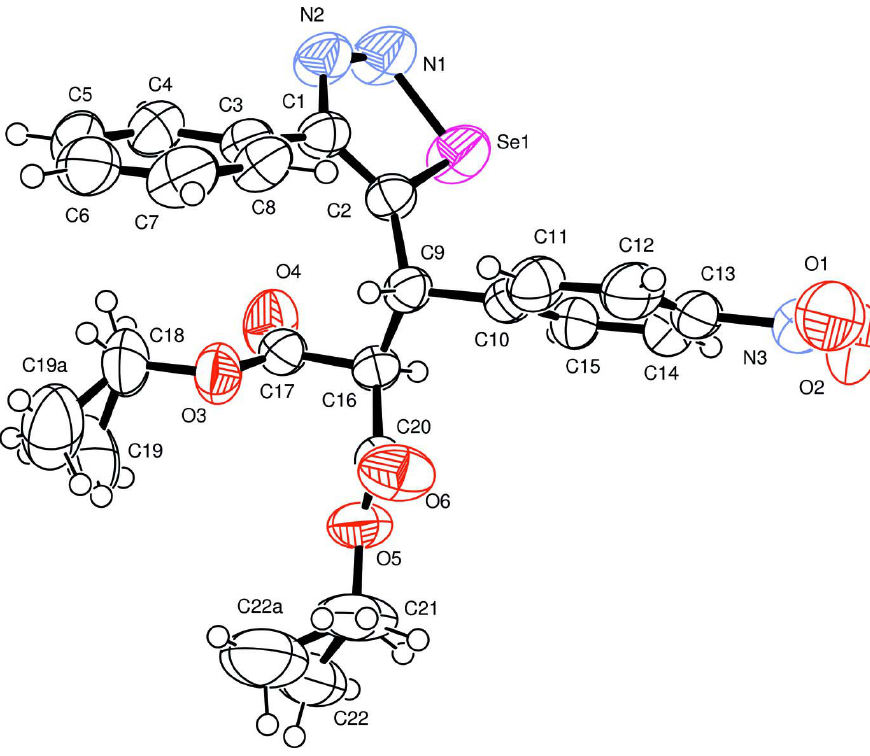
Figure 1 The molecular structure of (I), with atom labels and 50% probability displacement ellipsoids for non-H